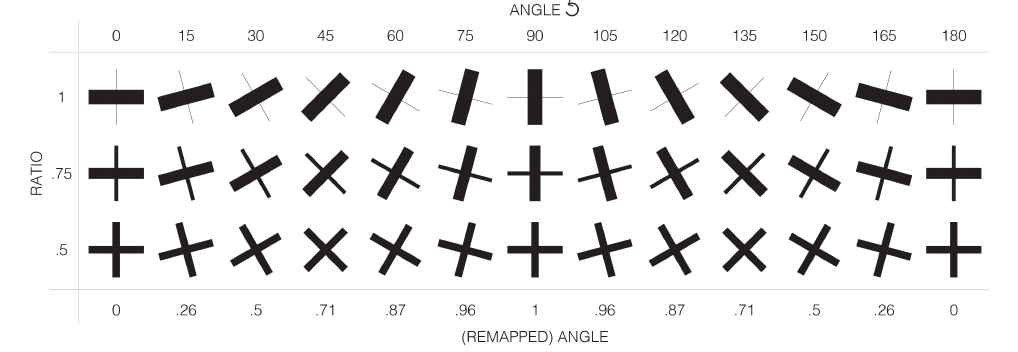
Figure 13. Graph showing remapping of ratio and angle